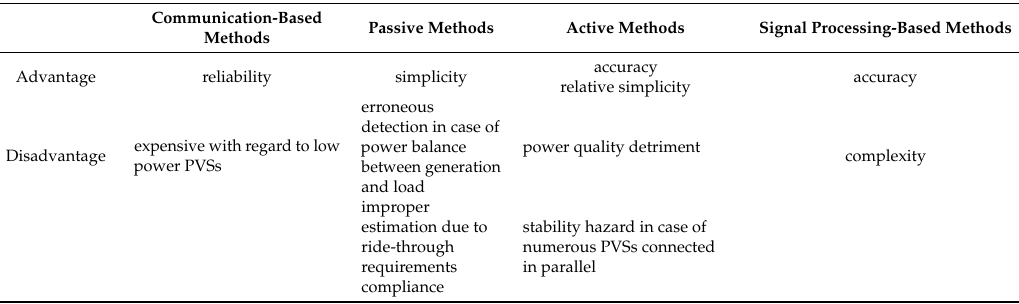
Table 2. Advantages and disadvantages of the islanding detection